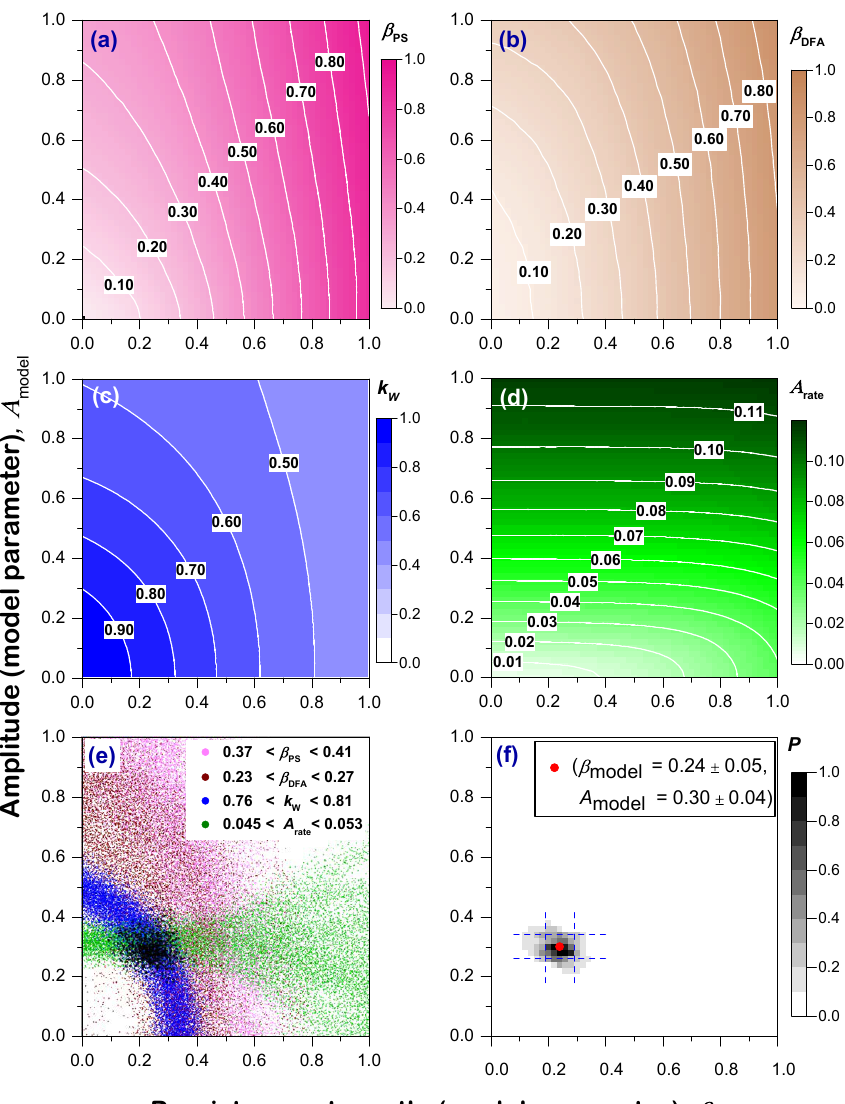
Figure 14. Analysis of model realizations of the POT FGN + Period model (peaks over thresholds (POTs) of a (FGN + period)) with different pairs of parameters for persistence strength and amplitude of the periodic component. Given for all six panels are the two model parameters of the POT FGN + Period : (i) strength of long-range persistence of the underlying fractional Gaussian noise (FGN) β model = 0 . 00 to 1.00 (step size 0.02) on the x -axis and (ii) the amplitude of the superimposed periodic component (period T = 2030 years), A model = 0 . 00 to 1.00 (step size 0.02) on the y -axis. For each of the 51 × 51 = 2601 pairs of model parameters ( β model ,A model ) , 1000 realizations were produced. Each realization is a synthetic floods per year series which is constructed as described in Sect. 5.1 and illustrated in Fig. 12. In (a) , (b) , (c) , and (d) are given respectively the mean of the measured β PS , β DFA , k W , and A rate (see the legend for colours and contours) for the 1000 realizations in each of the 51 × 51 cell parameter pairs ( β model , A model ) . In (e) , we then take measured values from each of the panels (a) to (d) and show in (e) their corresponding ( β model , A model ) values. The measured values are chosen from each panel to be the same range (with error bars) as our Piànico palaeoflood data as follows: (i ) strength of persistence, 0.370 ≤ β PS ≤ 0 . 410, 5000 values from panel a, magenta dots; (ii) strength of persistence, 0.23 ≤ β DFA ≤ 0.27, 5000 values from b) , brown dots; (iii) shape parameter of the Weibull distribution, 0.77 ≤ k W ≤ 0.81, 5000 values from (c) , blue dots; and (iv) sinusoidal flood rate, 0.0450 ≤ A rate ≤ 0.0530, 5000 values from (d) , green dots. When a given realization has β PS , β DFA , k W , and A rate , all of which satisfy the preceding conditions (i.e. all four colours for a given realization appear in e ), then we give a black dot. In (f) , the 2-D probability density of model parameters ( β model , A model ) is shown whose persistence strength ( β DFA ) , shape parameter of the Weibull distribution ( k W ) , and best-fitting sinusoidal flood rate have similar values to that of the Piànico palaeoflood record (see the legend for the colour code). Marked is the mode (red bullet) and the area that contain approximately 50% of the points (blue dashed